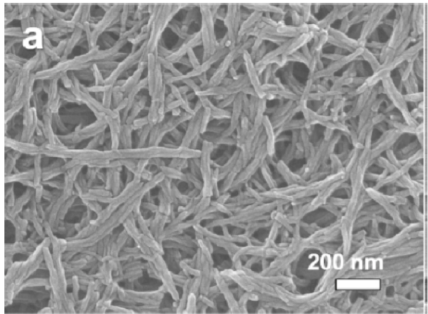
Figure 7: SEM of PANi-CNT fiber [30]. Reprinted from